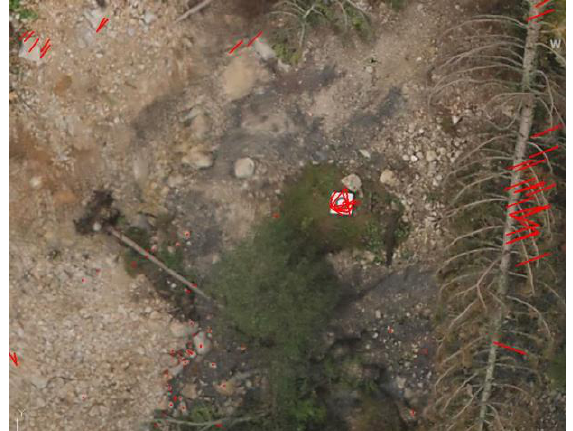
Figure 7. Subset of regular grid of vectors drawn over digital orthophoto with contours marking the magnitude of vectors. Contour equidistance 0.1